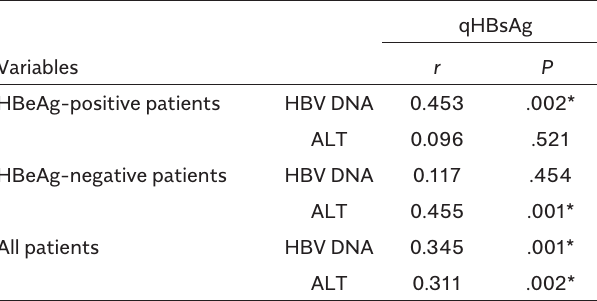
Table 2. Correlations Between qHBsAg, HBV DNA, and ALT Levels